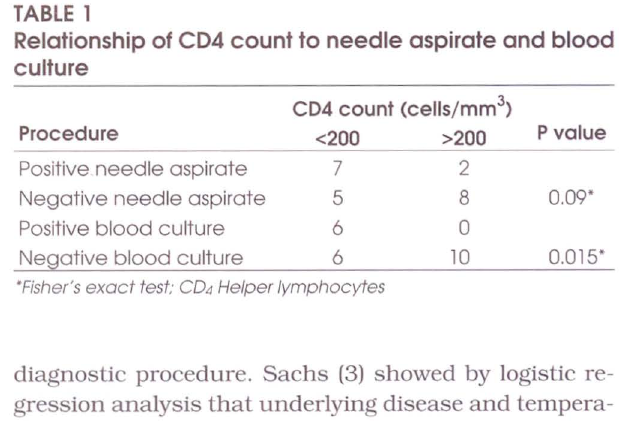
Relationship of CD4 count to needle aspirate and blood